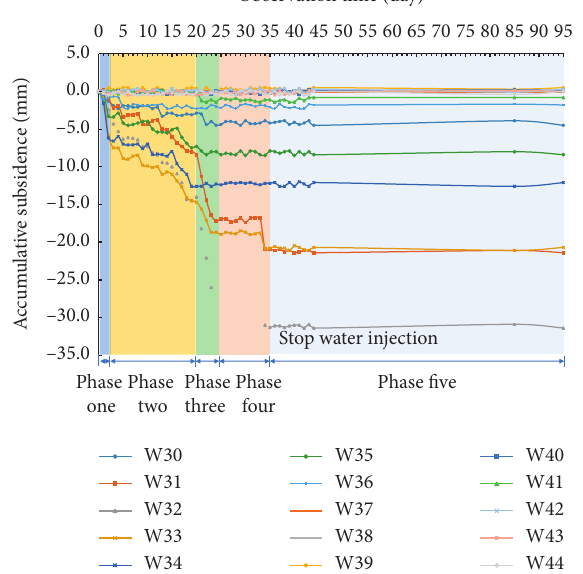
Figure 9: Typical accumulative surface subsidence curves (shallow markers of survey line